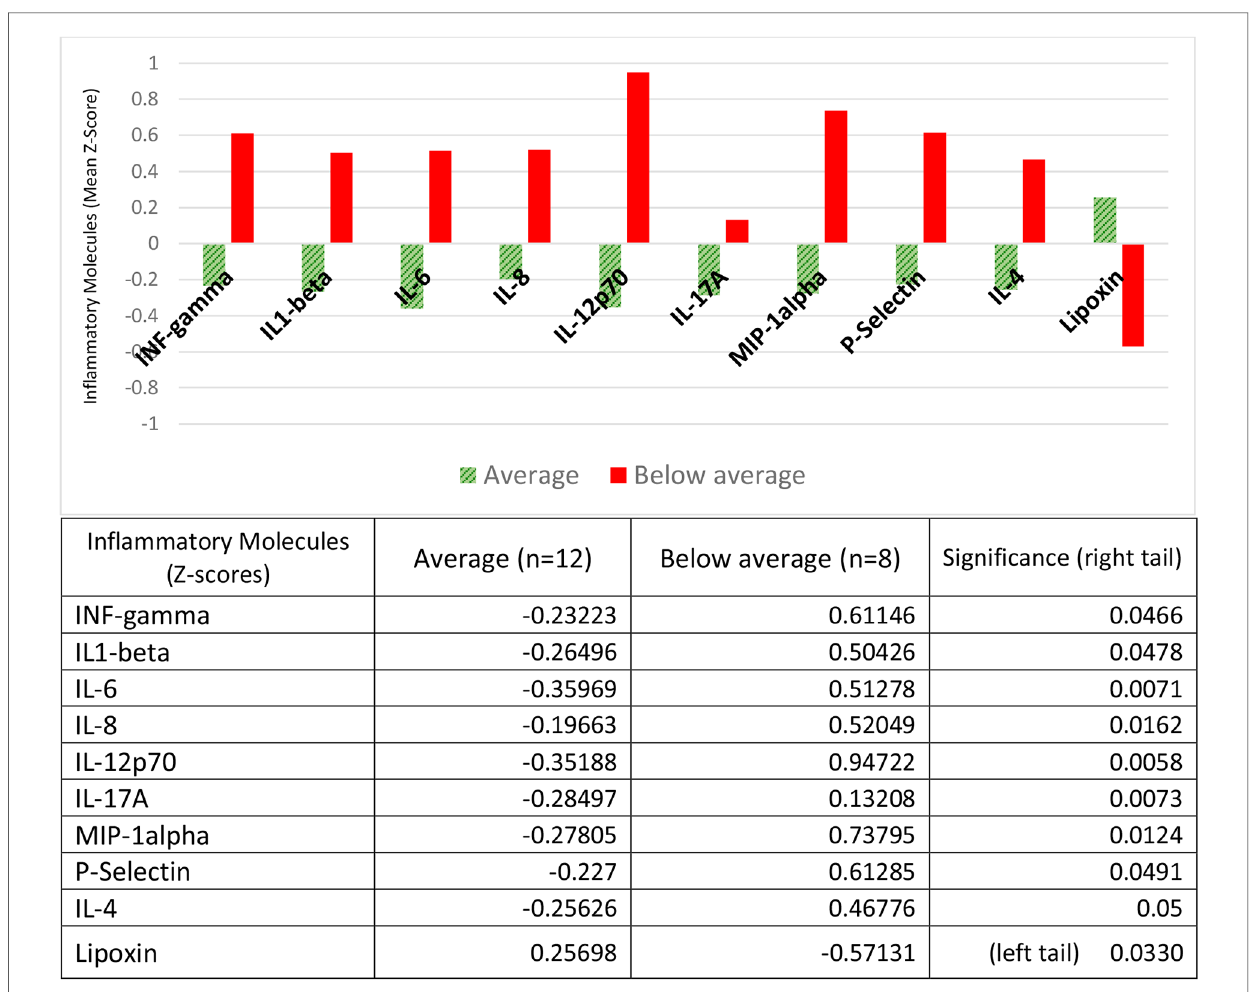
FIGURE 4 In fl ammatory molecules and alterations in child cognitive development. Children with cognitive impairment (below average) had positive Z -scores for mean concentrations of the proin fl ammatory molecules IL1-beta, IL-6, IL-8, IL-12p70, IL-17A, MIP-1-alpha, INF-gamma and P-Selectin, and the anti- in fl ammatory cytokine IL-4; children with average (normal) cognitive development had negative Z -scores for all these cytokines. Pro-resolving lipoxin had negative Z -scores in the cognitively impaired group and positive Z -scores in the cognitively normal group. The table expresses the complete numerical data and the signi fi cances between the